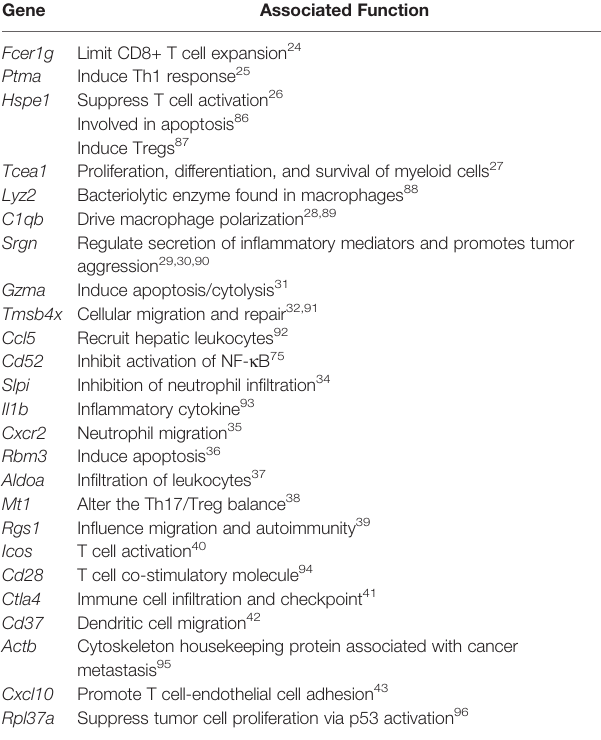
TABLE 1 | Percentage of cells in each cluster from scRNA-seq. Column1